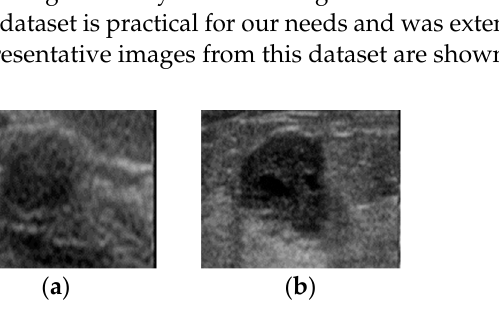
Figure 2. Representative images from Mendeley breast ultrasound dataset: ( a ) benign; ( b ) malig- nant.